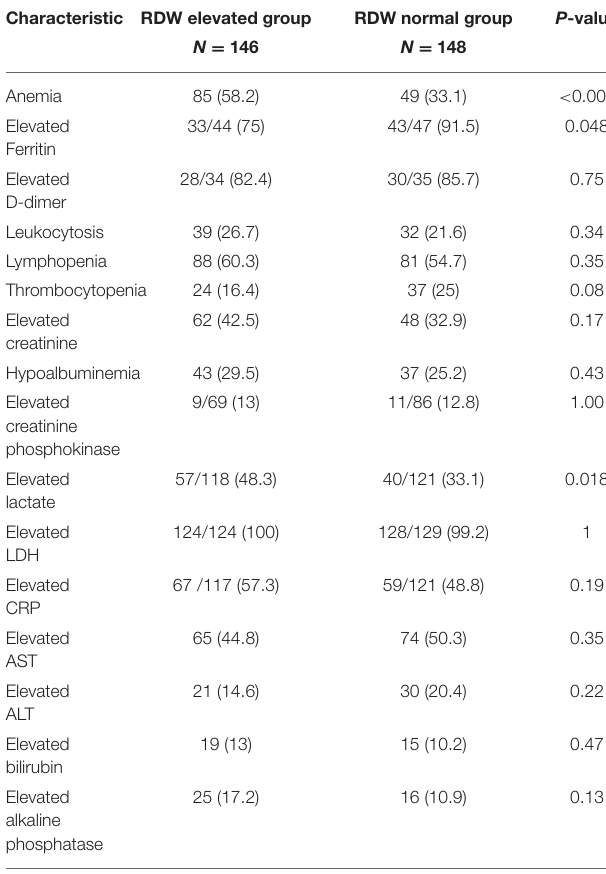
TABLE 2 | Laboratory data in hospitalized COVID-19 patients according to their red blood cell distribution width (RDW) value. Characteristic RDW elevated group RDW normal group